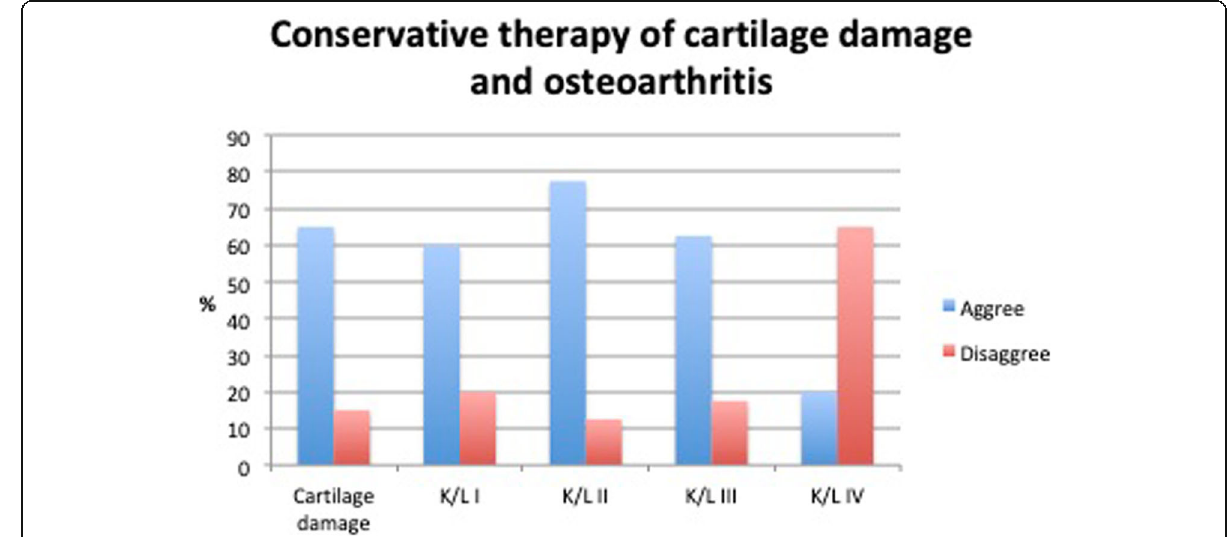
Fig. 3 Recommended use of PRP for conservative therapy of cartilage damage and osteoarthritis